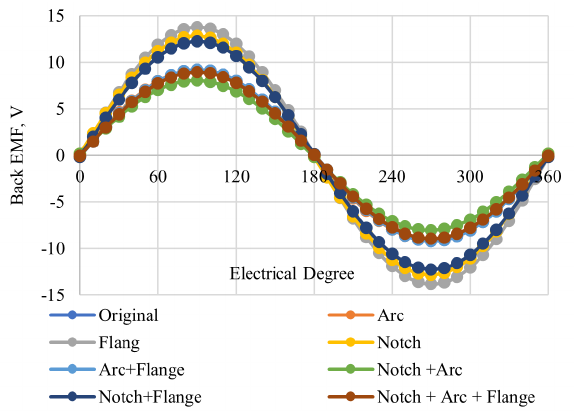
Figure 29. The no-load back-EMF of all models.